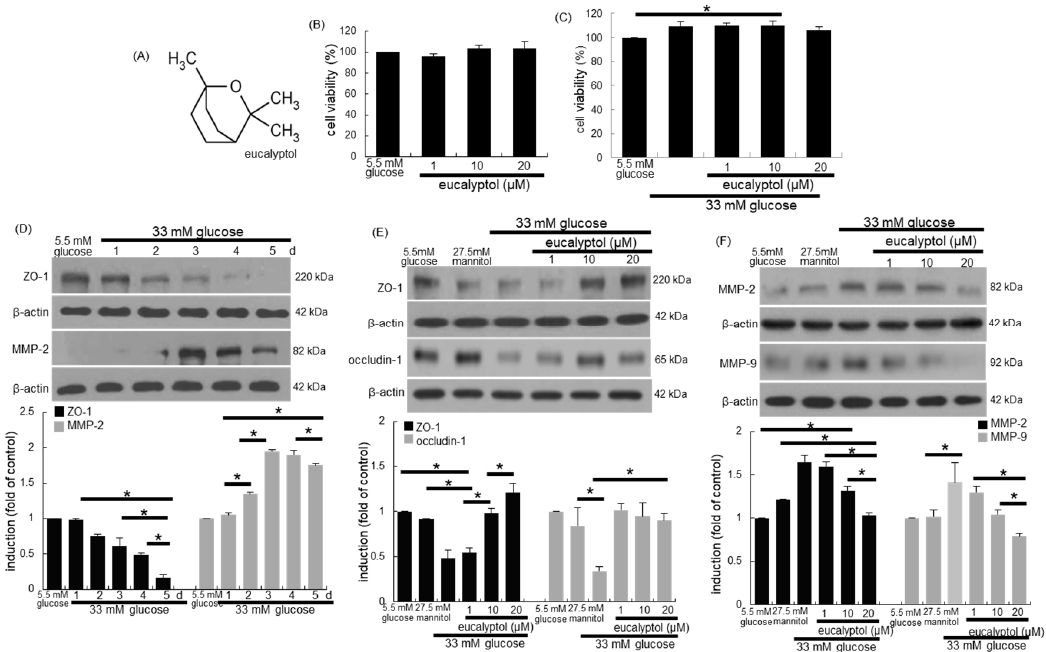
Figure 1. Chemical structure of eucalyptol ( A ), toxicity of eucalyptol-treated human retinal pigment epithelial (RPE) cells ( B ), inhibitory e ff ects of eucalyptol on proliferation of glucose-exposed RPE cells ( C ), temporal responses of epithelial induction of ZO-1 and MMP-2 ( D ) and e ff ects of eucalyptol on tight junction proteins of ZO-1, occludin-1, MMP-2 and MMP-9 injured by glucose ( E and F ). An MTT assay was conducted for measurement of cell viability ( B and C , 100% viability with 5.5 mM glucose control). Bar graphs for viability (mean ± SEM, n = 5) was expressed as the percentage of cell survival, compared to the glucose control. Cell lysates were subject to western blot analysis with a primary antibody against ZO-1, occludin-1, MMP-2, MMP-9 and β -actin for a cellular internal control ( D – F ). Bar graphs (mean ± SEM, n = 3) in the panels represent densitometric results of blot bands. * Values in respective bar graphs indicate a significant di ff erence at p < 0.05.